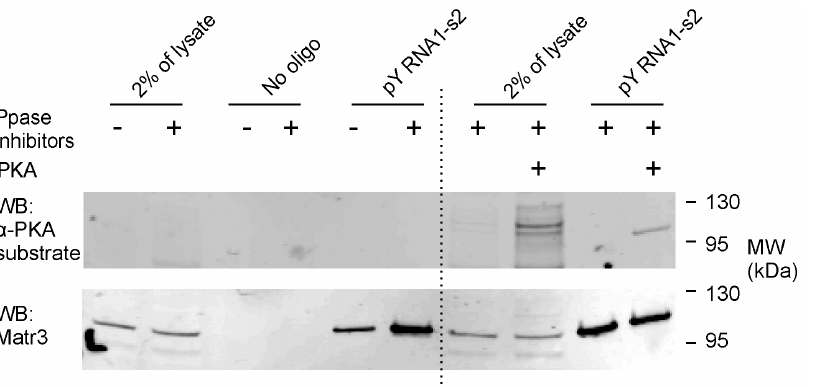
Figure 10. Phosphorylation enhances the interaction between Matr3 and pY RNA1-s2. Pre-conjugated biotinylated pY RNA1-s2: streptavidin beads (indicated with ‘‘pY RNA1-s2’’) were incubated with retina lysates prepared from six animals, as described in ‘‘Materials and Methods’’. Negative control binding assays are labeled ‘‘control’’. Load controls are indicated with ‘‘2% of lysate’’. The recovered proteins were subjected to SDS-PAGE and western blotting using an antibody raised against a generic phosphorylated substrate ( a -PKA substrate) followed by re- probing against Matr3. Prior to the binding assay, retina lysates were prepared in the absence ( 2 ) or presence ( + ) of phosphatase inhibitors (Ppase inhibitors) or recombinant protein kinase A (PKA), to enhance phosphorylation of endogenous Matr3. See ‘‘Materials and Methods’’ for details of inhibitors and PKA used. The lower panel shows a re-probe using an anti-Matr3 antibody of the upper blot.